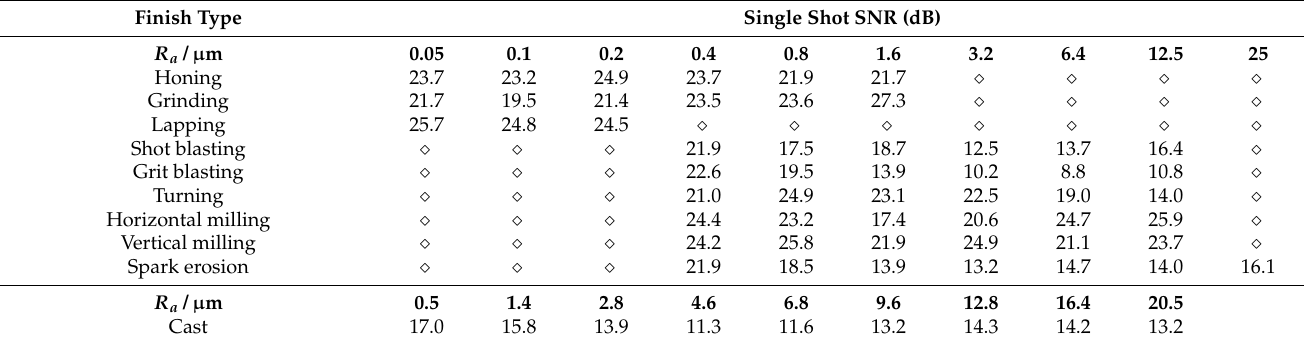
Table 3. Single-shot average SNR (dB) for all valid data points taken on each roughness comparator using the Quartet detector.